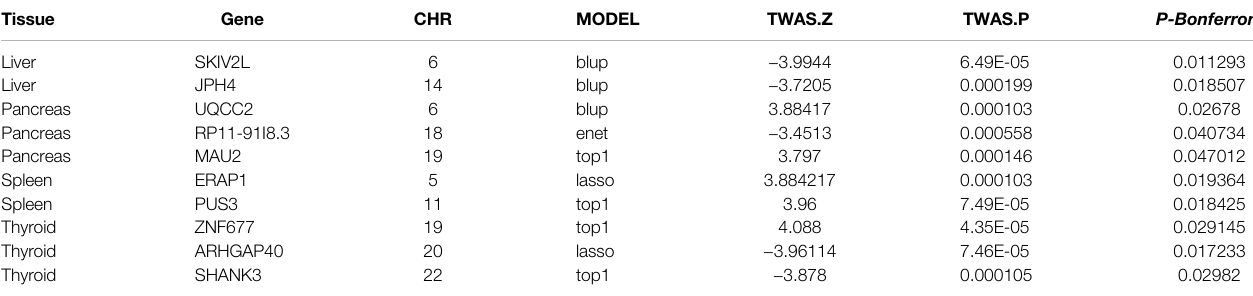
TABLE 1 | Genes signi fi cantly associated with risk of cirrhosis.